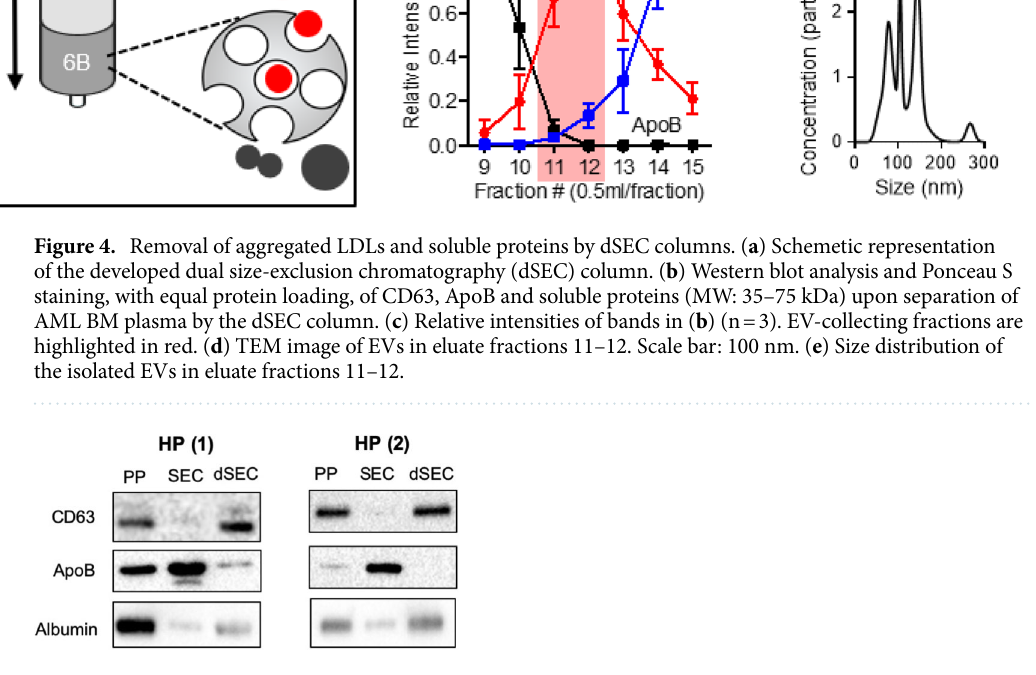
Figure 5. Comparison of the performance of the developed dSEC column and against conventional isolation methods. Western blot analysis of CD63, ApoB and albumin upon isolation of BM plasma (HP) by polymer- based precipitation (PP), conventional SEC (CL-2B), and the dSEC